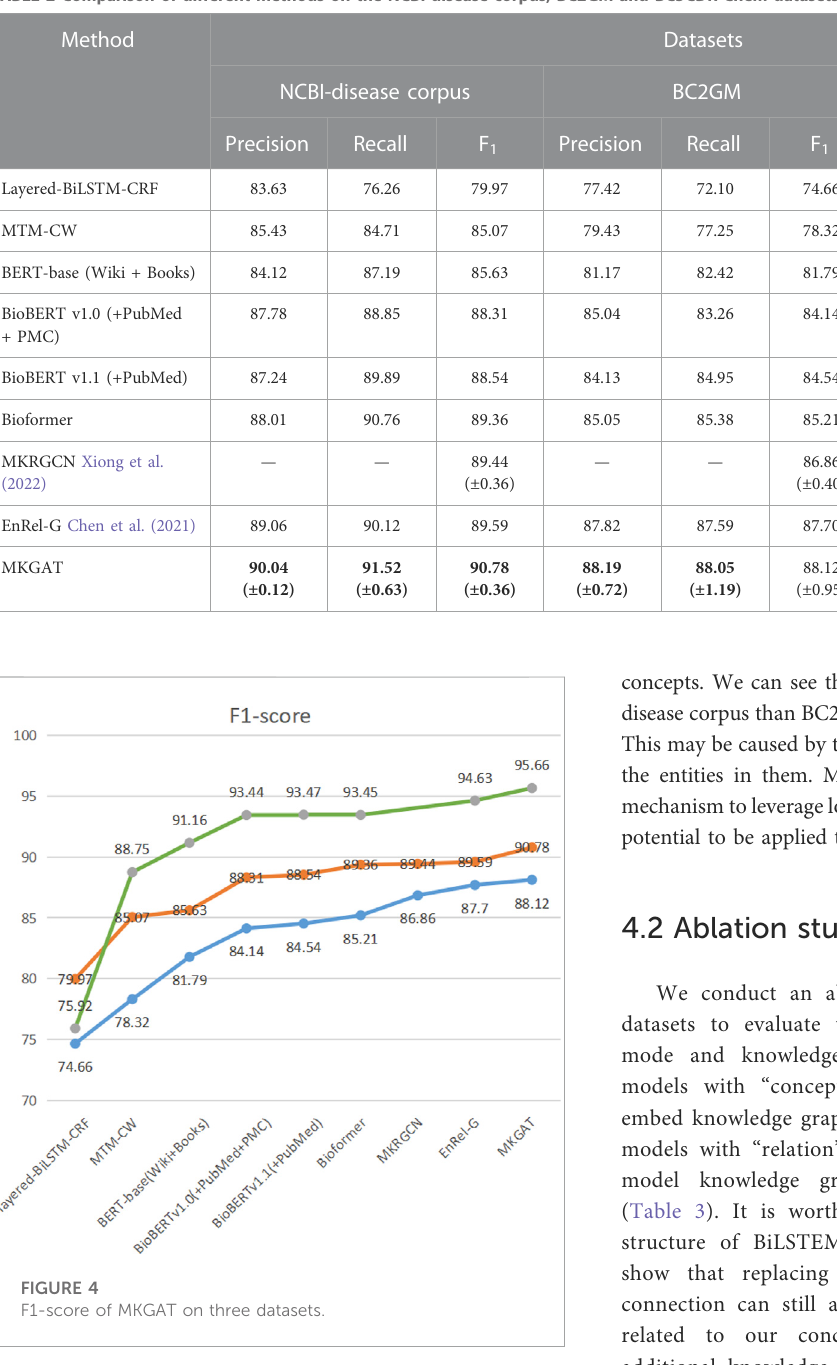
TABLE 2 Comparison of different methods on the NCBI-disease corpus, BC2GM and BC5CDR-Chem datasets.